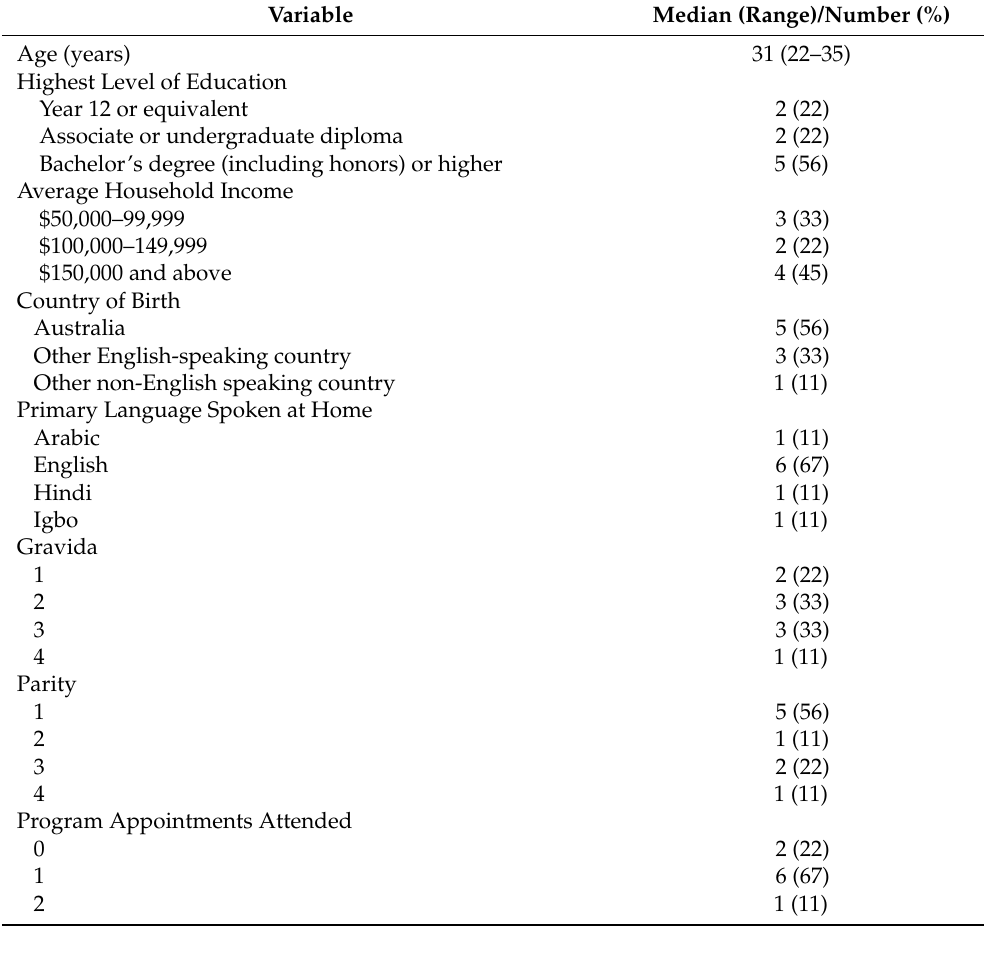
Table 1. Characteristics of women consenting to telephone interviews ( n = 9).